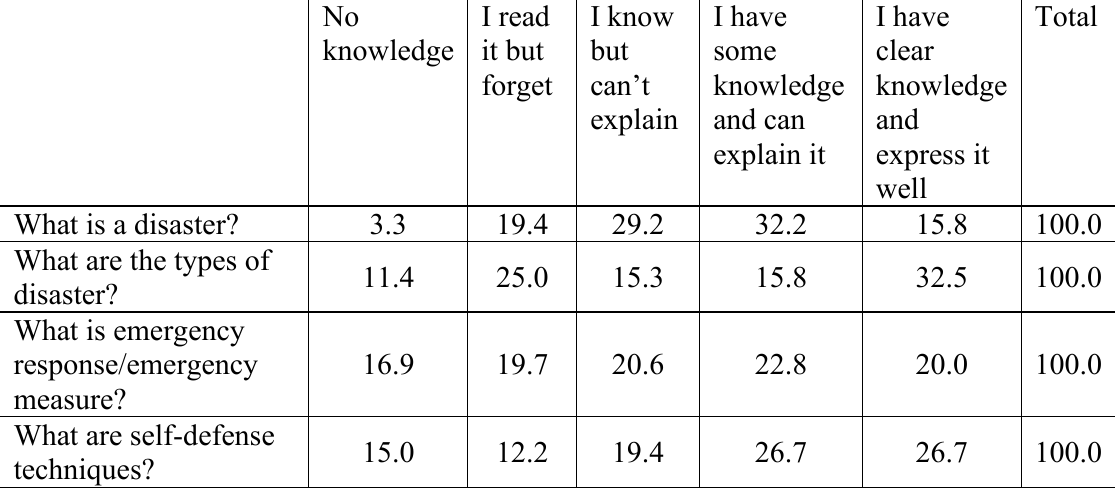
DISASTER , EMERGENCY RESPONSE , AND SELF - DEFENCE TECHNIQUES